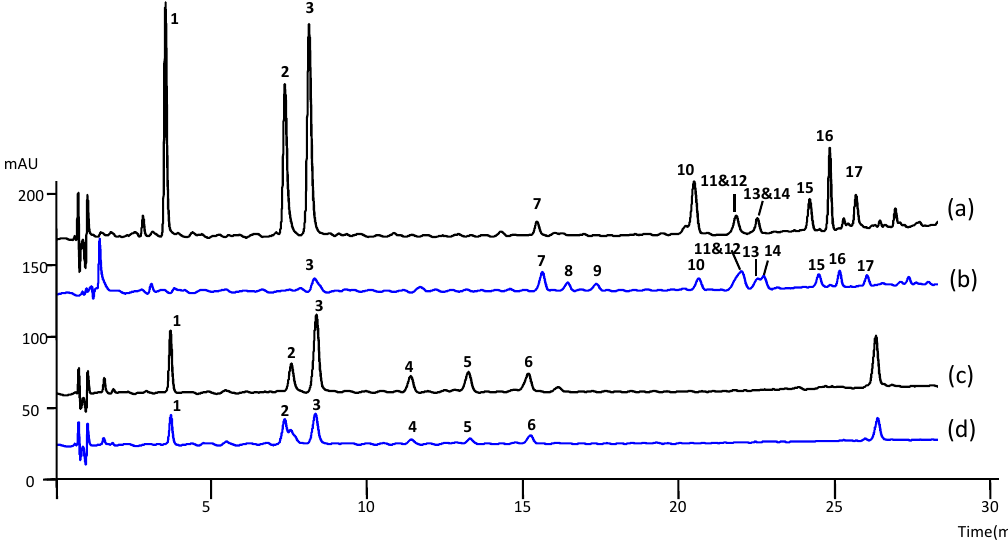
Figure 2. Representative chromatograms of ( a ) leaflet extracts of Oenocarpus bataua ; ( b ) leaflet extracts of Oenocarpus bacaba ; ( c ) root extracts of Oenocarpus bataua ; ( d ) root extracts of Oenocarpus bacaba at λ = 320 nm; Kinetex PFP column, (100 × 4.6) mm, 2.6 µm. ( 1 ) 3-CQA, ( 2 ) 4-CQA, ( 3 ) 5 CQA, ( 4 ) 4-CSA, ( 5 ) 5-CSA, ( 6 ) CSA, ( 7 ) 6,8-di-C-hexosyl apigenin, ( 8 , 9 ) 6,8-di-C-hexosyl apigenin sulfate, ( 10 , 14 , 15 ), 6-C-hexosyl-8-C-pentosyl apigenin isomers, ( 12 , 16 ) 6-C-pentosyl-8-C-hexosyl apigenin isomer, ( 11 ) 8-C-glucosyl luteolin, ( 13 ) 6-C-glucosyl luteolin, ( 17 ) 6-C-glucosyl apigenin.